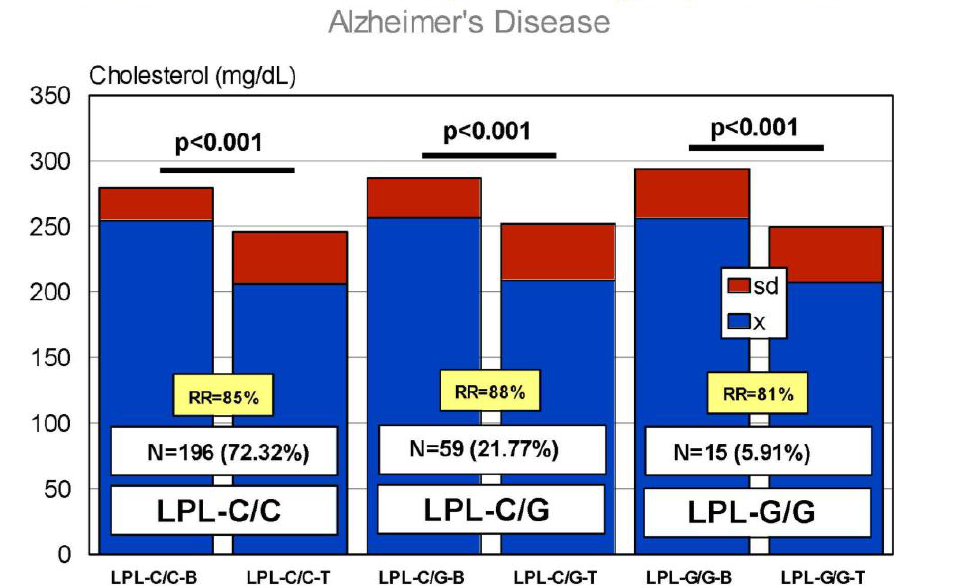
Figure 12. LPL -related cholesterol response to a hypolipemic treatment in hypercholesterolemic patients with Alzheimer’s disease (Atorvastatin: 10–20 mg/day; LipoEsar: 500 mg/day). CYP haplotype-related blood total CHO levels are very heterogeneous, but absolute values of total CHO among the most frequent haplotypes are almost identical. The histograms of frequency associated with CHO levels are qualitatively different among carriers of different CYP variants. Basal CHO levels are higher in AD patients harboring the CYP2D6 - *1 / *1 and *1xN / *1 genotypes than in the corresponding GP genotypes, but no differences have been found according to the EM, IM, PM, or UM condition. The therapeutic response according to SNPs of metabolic genes ( CYP2D6 , CYP2C9 , CYP2C19